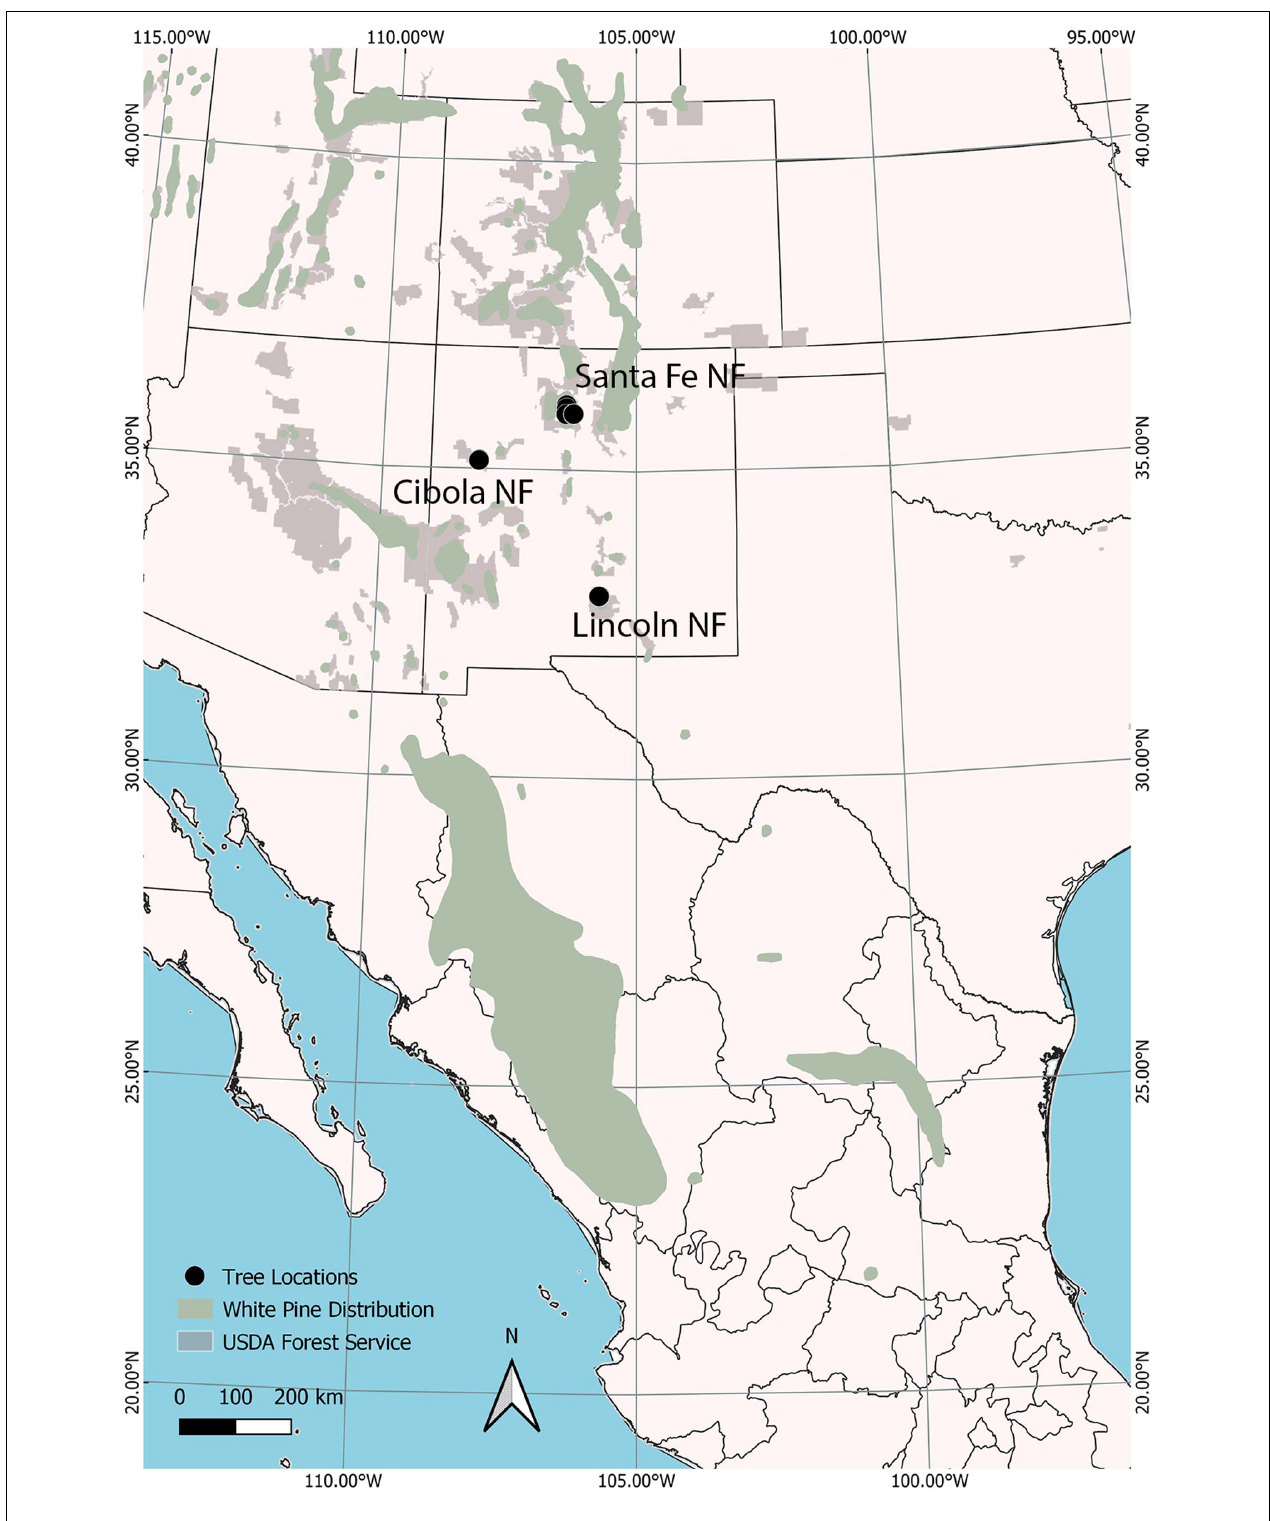
FIGURE 1 | Open-pollinated cones from 40 trees were selected from three national forests (black dots): The Santa Fe in northern New Mexico, Cibola in western New Mexico, and the Lincoln in southern New Mexico. These population represent a portion of the disjunct northern periphery of the Pinus strobiformis range (extending south into Mexico) within the range of white pines (green). USDA Forest Service unit boundaries are shown in light gray.